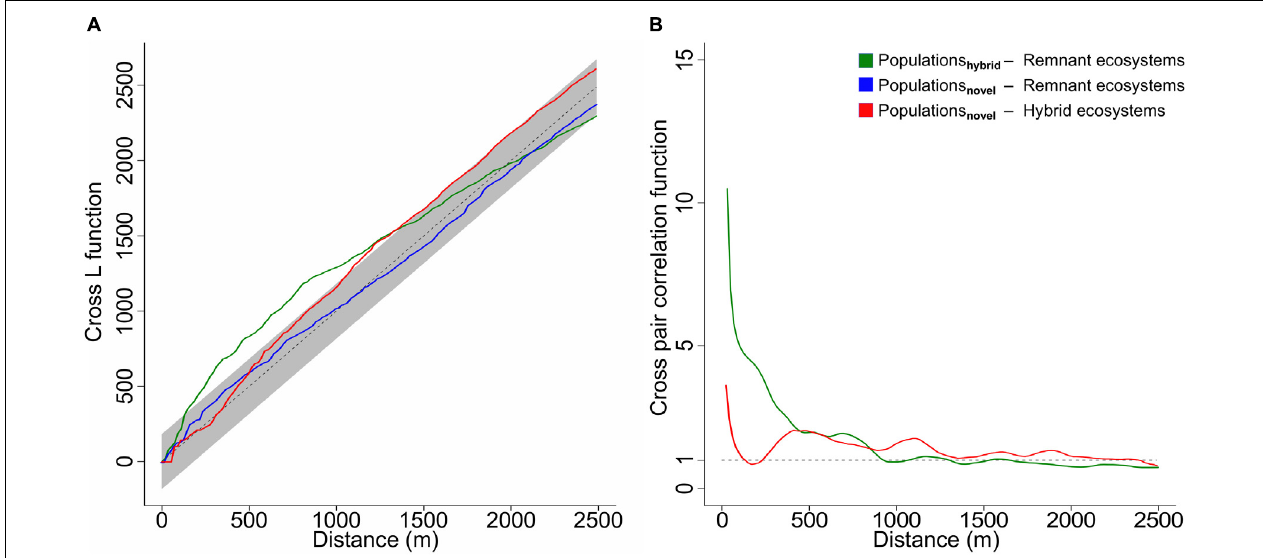
FIGURE 3 | (A) Cross L function showing significant ( p < 0.05) spatial correlations at increasing distances between populations in hybrid ecosystems ( n = 632) and remnant ecosystem patches ( n = 3426) (green line) and between populations in novel ecosystems ( n = 687) and hybrid ecosystem patches ( n = 15681) (red line), as in all these cases the line of the observed point process crosses at some point outside of the boundaries of the global envelope of the null model (dashed line with gray envelope generated from 19 simulations). No spatial correlation (independence) was found (95% confidence level) between populations in novel ecosystems ( n = 687) and remnant ecosystem patches ( n = 3426) (blue line), as the observed curve of the point process (blue line) does not cross outside of the boundaries of the global envelope of the null model. (B) Cross pair correlation function showing the type of correlation at increasing distances between populations in hybrid ecosystems ( n = 632) and remnant ecosystem patches ( n = 3426) (green line) and between populations in novel ecosystems ( n = 687) and hybrid ecosystem patches ( n = 15681) (red line). Values higher than 1 (dashed line) indicate an increasingly stronger positive correlation (dependence). Please note that the blue line is not represented as there is spatial independence between populations in novel ecosystems and remnant ecosystems ( Figure 3A